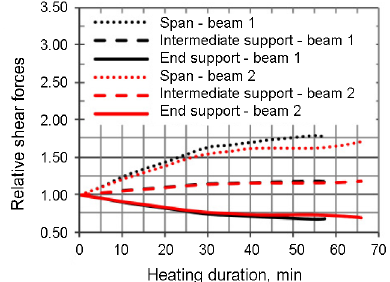
Fig. 9. Relative changes of shear forces: in the middle section of the span and at supports: intermediate and end